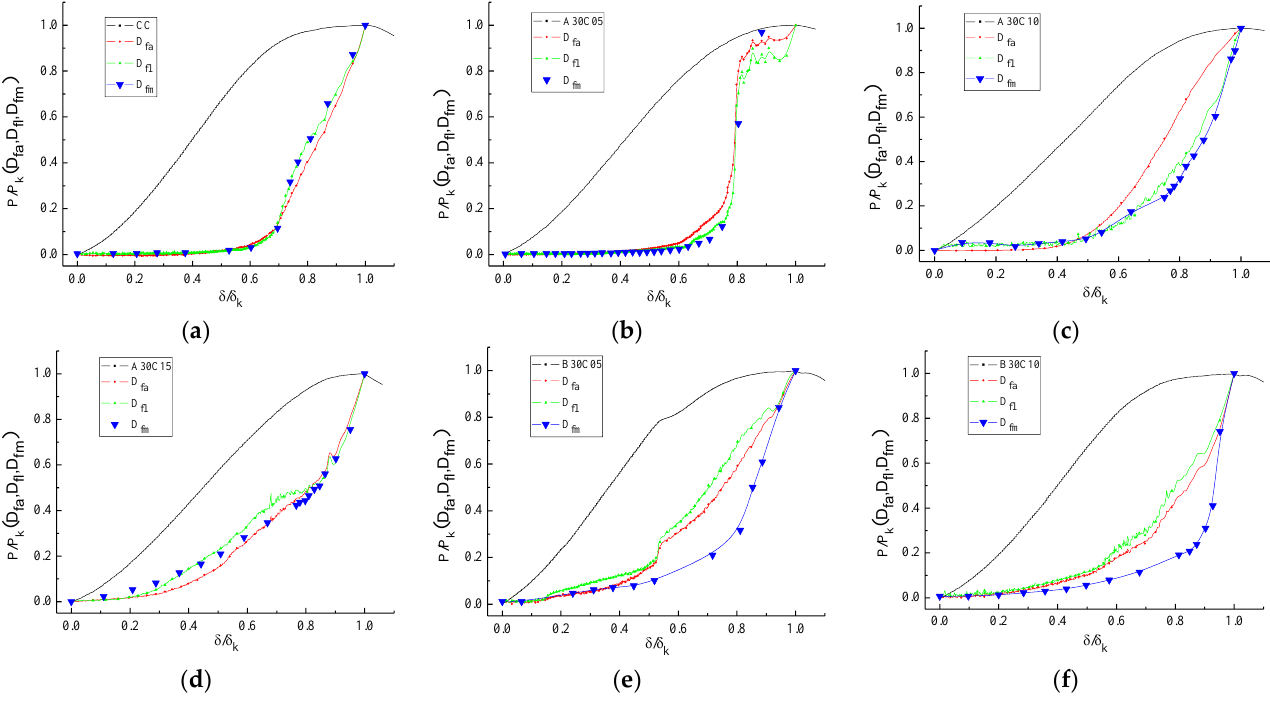
Figure 8. Damage evolution curve of PNFRC samples. ( a ) CC, ( b ) A30C05, ( c ) A30C10, ( d ) A30C15, ( e ) B30C05, and ( f ) B30C10.